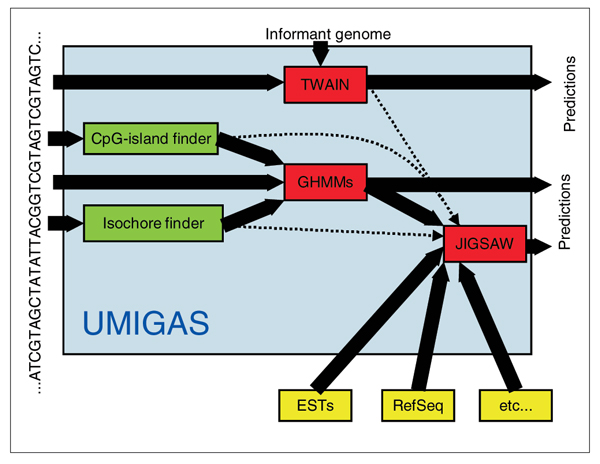
The computational gene finding pipeline UMIAGS (University of Maryland Integrative Analysis of Gene Structure). The raw genomic sequence is shown as an input at left; gene structure predictions are emitted at right. Additional evidence tracks for the combiner program JIGSAW are shown entering from the bottom. See text for details. GHMM, generalized hidden Markov model.